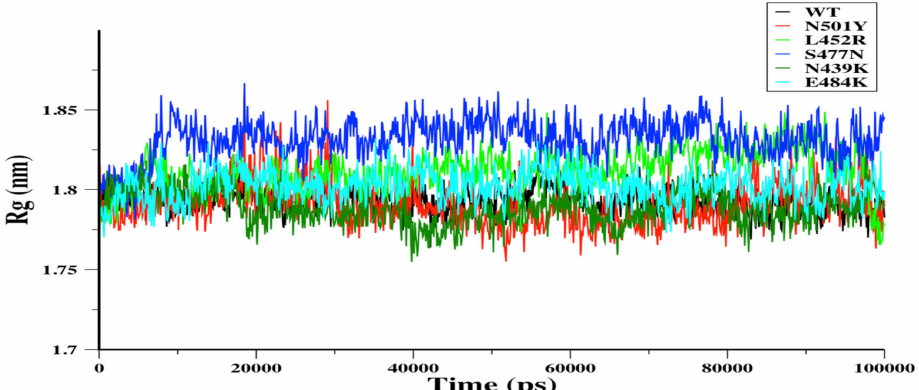
Figure 4. The radius of gyration (Rg) in nm was plotted versus simulation time (ps). WT (black), N501Y (red), N439K (green), and E484K (cyan) RBDs showed a relatively similar Rg for all of the simulations ( a ). L452R (light green) and S477N (blue) were different from WT RBD over most of the 100-ns simulations. However, L452R showed similar conformations in the last frame of MD